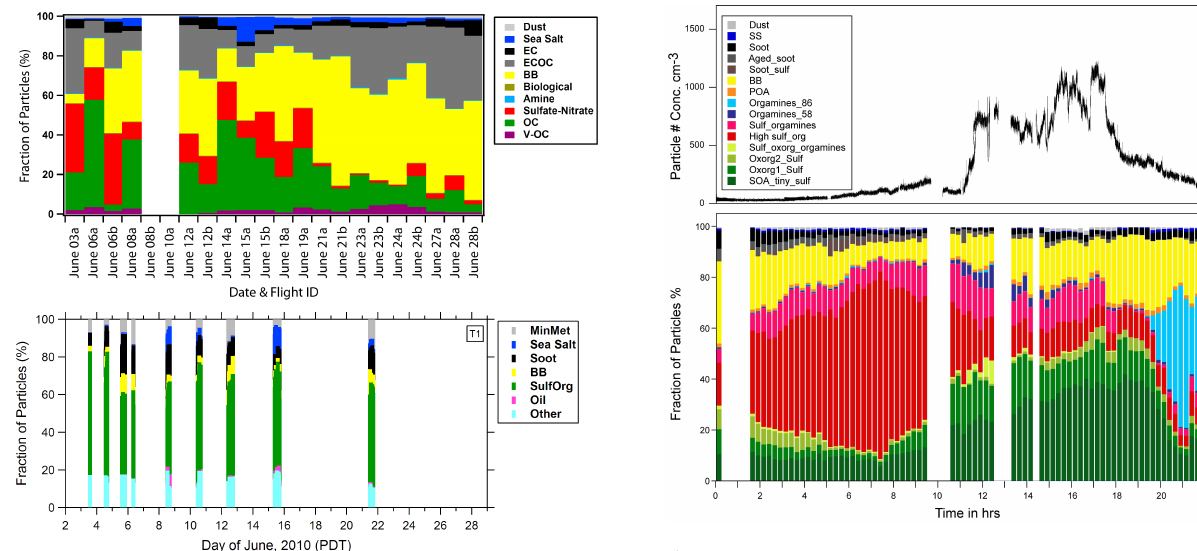
Fig. 13. Temporal evolution of particle number concentration (up- per panel) and the corresponding fraction of particles with different compositions (lover panel) as observed by SPLAT II on 6 June at the T0 site. SS is sea salt, BB is biomass burning particles.